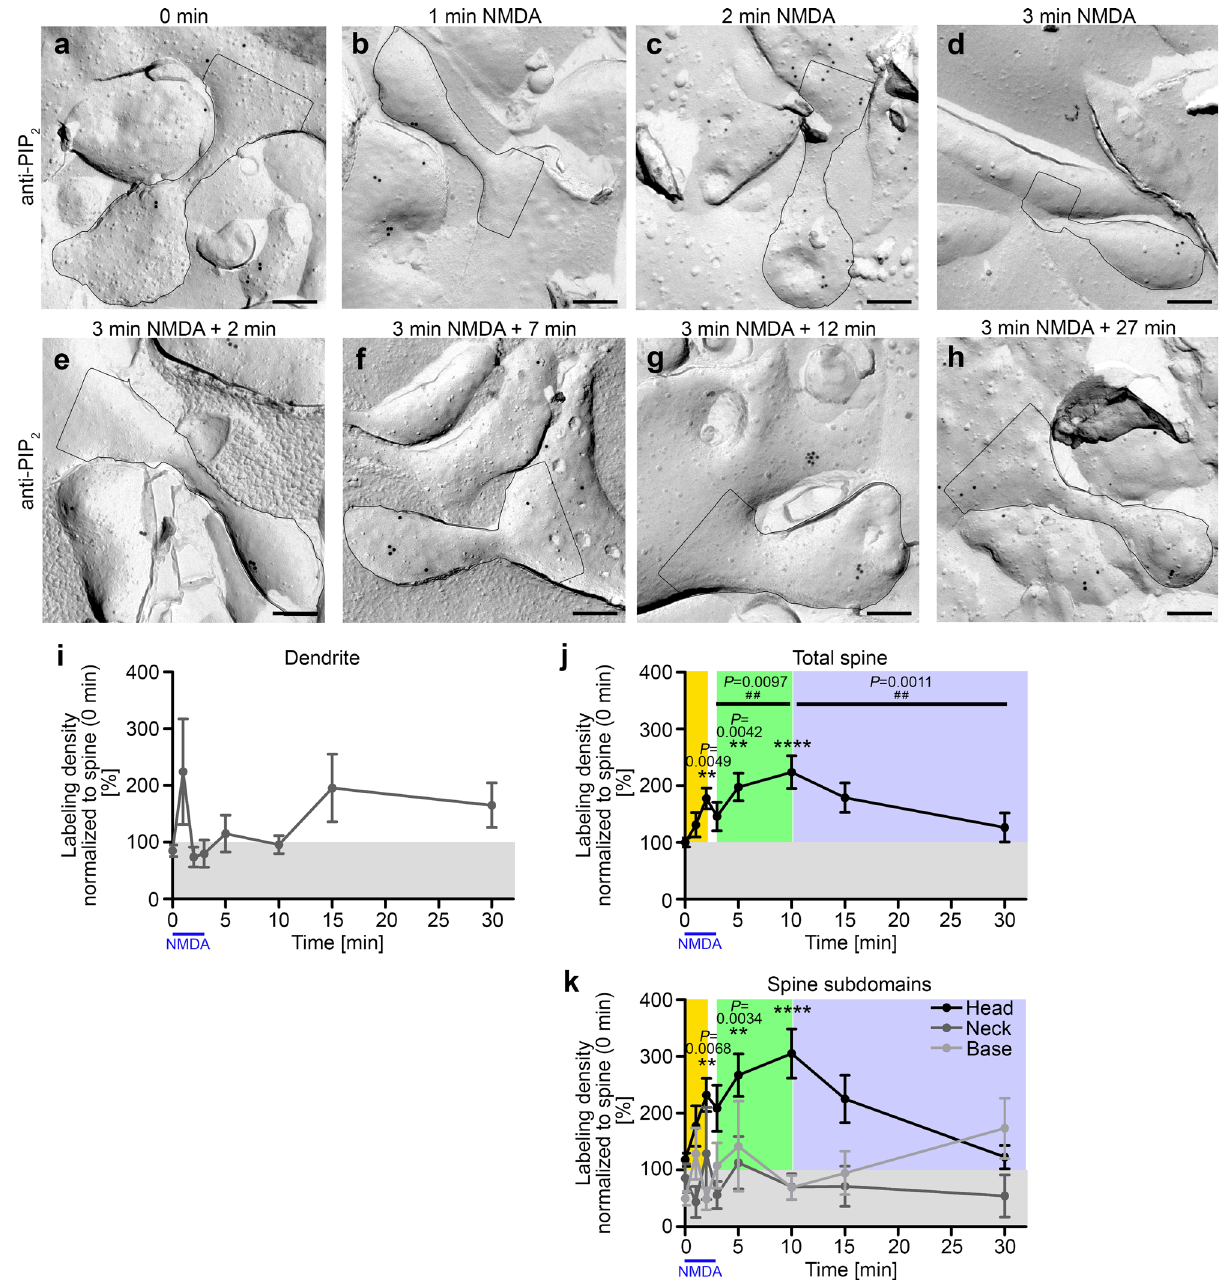
Fig. 3 PIP2 transiently increases after LTD induction in dendritic spines. a – h TEM images of anti-PIP 2 immunogold-labeled dendritic spines (outlined) of freeze-fractured hippocampal neurons (DIV14-16) at steady state (0 min) and at different times during and after LTD induction by incubation with 50 µ M NMDA for 3 min and subsequent placing back into preconditioned medium. Bars, 200 nm. i – k Quantitative determinations of anti-PIP 2 immunogold labeling densities at different treatment times during and after LTD induction determined in dendrites ( i ), in total spines ( j ) and in the three different spine subdomains ( k ) expressed as percent of the average labeling density of the total spine data at 0 min (steady state) in each assay. Three apparent phases of PIP 2 signaling responses in dendritic spines during and after LTD induction are highlighted by coloring (yellow, phase 1, rapid fi rst increase of PIP 2 density; green, second phase of increase of PIP 2 signals in the spine (head) plasma membrane until a maximum is reached at 10 min; blue, phase 3, subsequent decreasing PIP 2 signals in the spine (head)). For a comparison of absolute data for 0 and 3 + 7 min not normalized to the respective controls with corresponding data obtained from an independent, untrained experimenter see Supplementary Fig. 3. ( i – k ) Data, mean ± SEM. 0 min, n = 159; 1 min, n = 36; 2 min, n = 53; 3 min, n = 49; 5 (3 + 2) min, n = 50; 10 (3 + 7) min, n = 59; 15 (3 + 12) min, n = 44; 30 (3 + 27) min, n = 35 ROIs each (dendrite; total spine; spine subdomains, base, neck, and head) from 3-16 independent assays with different incubation times. Statistical signi fi cance calculations, Kruskal – Wallis/Dunn ’ s ( i – k ; ** P < 0.01; **** P < 0.0001) and Mann – Whitney tests for 3 vs. 10 min and 10 vs. 30 min ( j ; ## P < 0.01) ( j ). For P < 0.0001, exact P- values are not available. Other P- values are reported directly in the fi gure. For numerical source data, see Supplementary Data